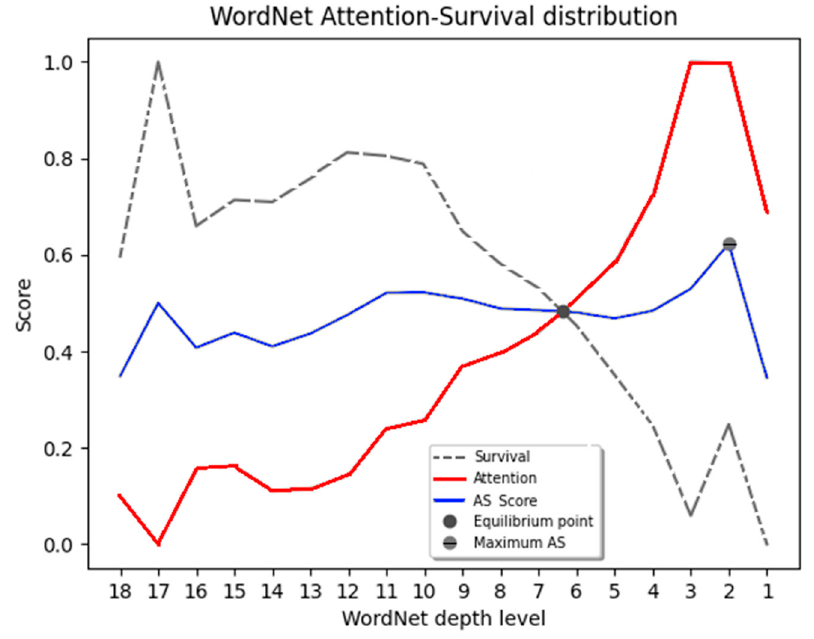
Figure 4. Evolution of attention, survival, and attention–survival score (AS) throughout the Word- Net structure. α = 0.5. structure. α =